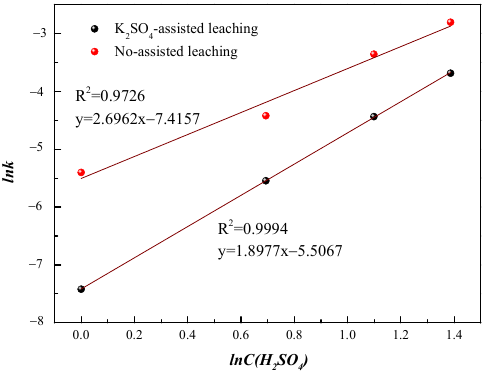
Figure 6. Plot of lnk as a function of sulfuric acid concentration.